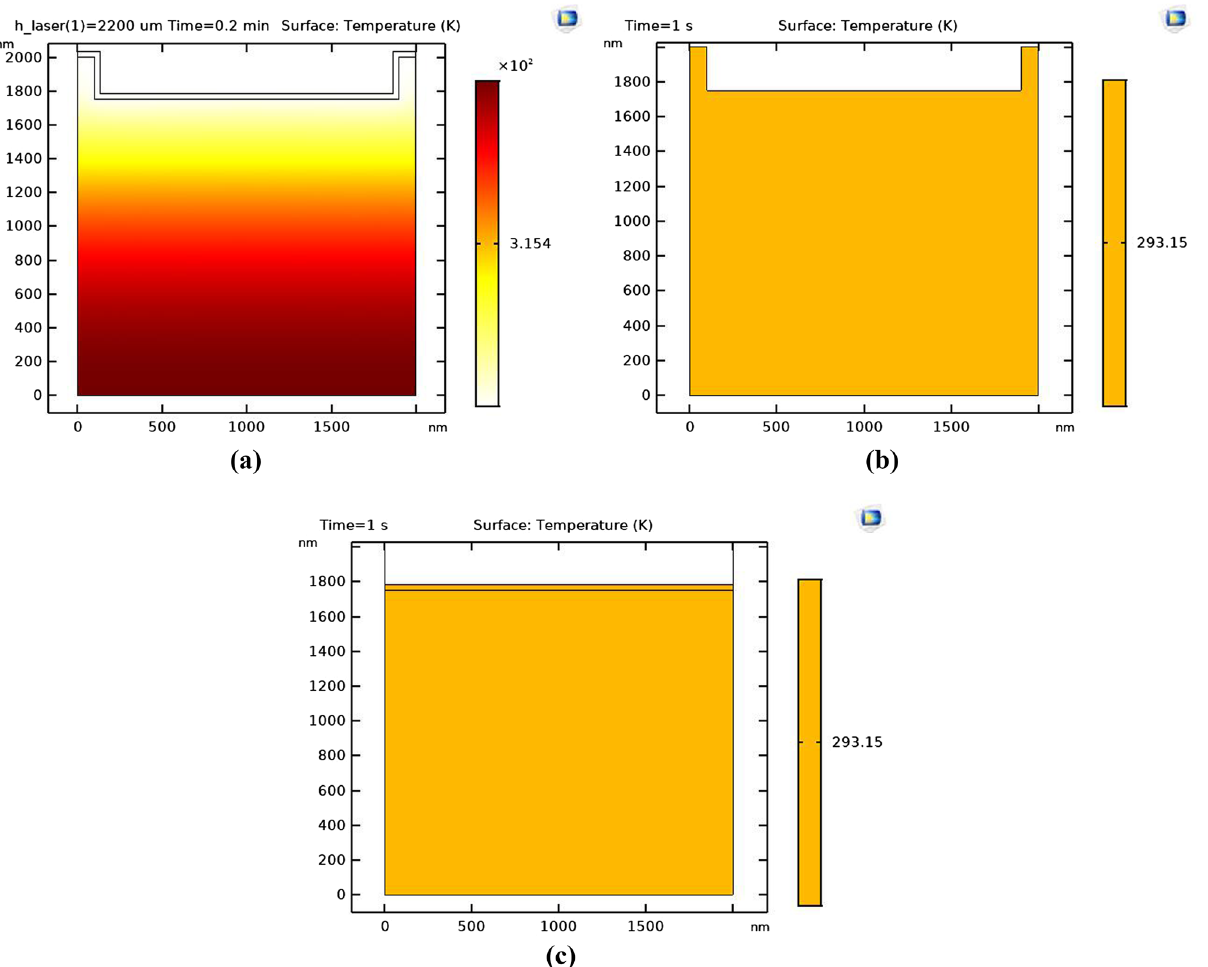
Figure 4. The temperature distribution across the ( a ) plasmonic sample with a nanostructured Au on Kapton substrate, ( b ) Kapton perforated substrate before gold coating and ( c ) Au thin film without any